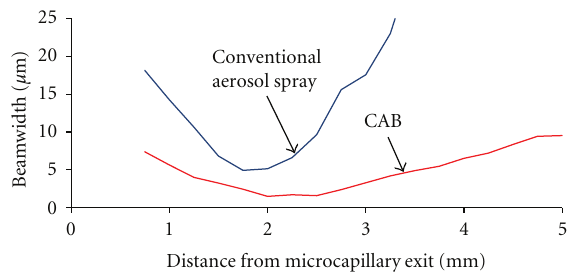
Figure 3: Graph of experimental aerosol beam width versus distance from the nozzle exit for (1) Aerosol Jet (conventional aerosol spray) and (2) CAB-DW, from Schulz et al. [18], Copyright 2010 IEEE.